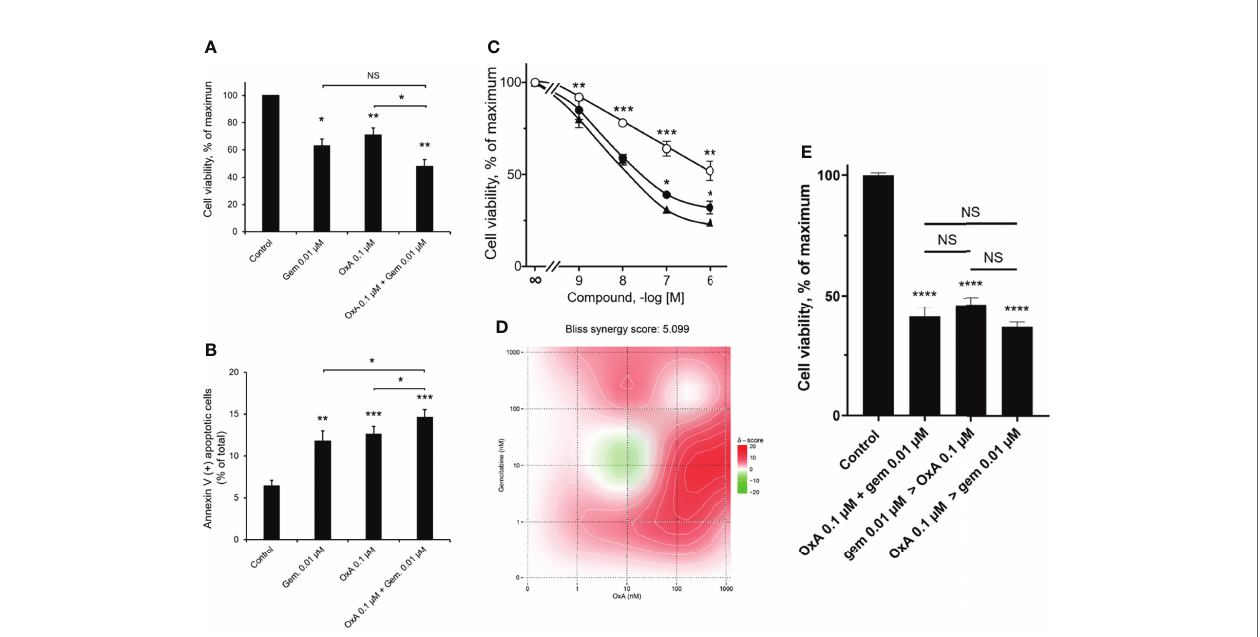
FIGURE 1 | Inhibition of AsPC-1 cell growth by OxA and/or gemcitabine. (A) Inhibition of AsPC-1 cell viability induced by 0.01 µM gemcitabine (gem), 0.1 µM OxA (OxA), or 0.01 µM gemcitabine plus 0.1 µM OxA. Results were expressed in the percentage of maximum obtained in the absence of treatment (control). (B) Effect of OxA or gemcitabine or their combination on apoptosis of ASPC-1 cells. Apoptosis was determined by annexin V/7-AAD binding, and results were expressed as the percentage of apoptotic cells. (C) Effect of the dose – response of OxA or gemcitabine or OxA plus gemcitabine on cell viability of AsPC-1 cells. (D) Bliss model diagram and estimation of Bliss synergy score. (E) OxA plus gemcitabine treatment and sequential treatment by OxA>gemcitabine or gemcitabine>OxA compared to control (absence of treatment). Results were expressed in the percentage of maximum obtained in the absence of treatment. Data were the means ± SEM of three separate experiments. ( ○ ) OxA, ( ● ) gemcitabine, and ( ▲ ) OxA plus gemcitabine. NS, non-signi fi cant, *p<0.05, **p<0.01, ***p<0.001, and ****p<0.0001 corresponding to comparison with